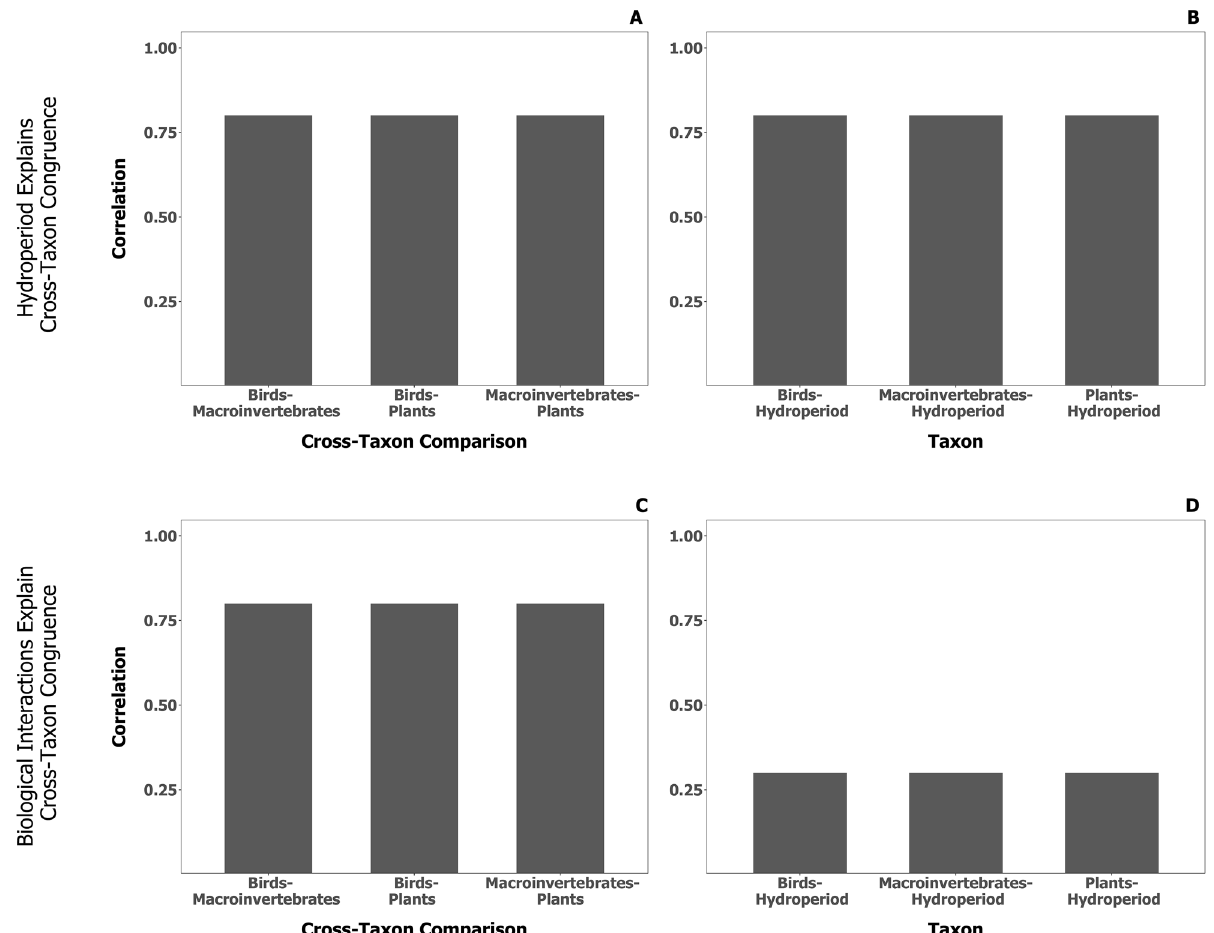
Figure 1. Hypothesized measures of congruence if cross-community congruence ( A ) was best explained by the influence of wetland hydroperiod ( B ), or if cross-community congruence was best explained by biological interactions ( C ) and not solely the influence of wetland hydroperiod ( D ). When the strength of cross- community relationships is similar in magnitude to that between each horizontal community and hydroperiod, we would expect that high cross-community congruence is explained by each horizontal community responding similarly to wetland hydroperiod ( A , B ). However, when cross-community relationships are much stronger than that between each horizontal community and hydroperiod, we would expect that high cross-community congruence is mostly explained by biological interactions ( C , D